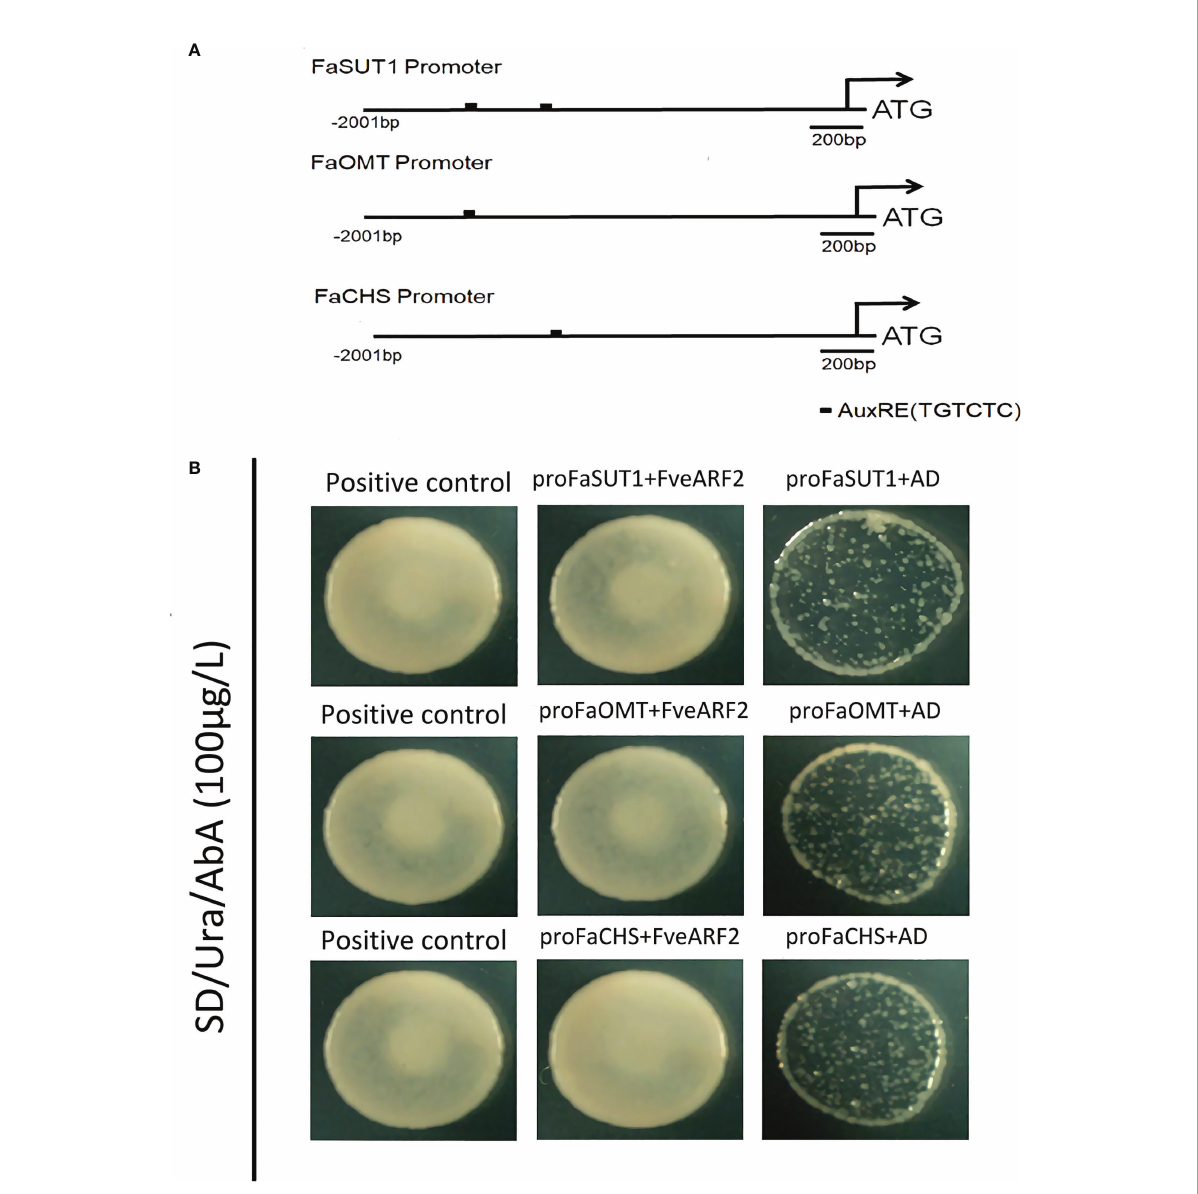
FIGURE 7 Y1H hybrid between FveARF2 and FaSUT1, FaOMT, and FaCHS promoters. (A) Structural diagram of FaSUT1 , FaOMT , and FaCHS promoters. The block represents the AuxRE element (TGTCTC). (B) FveARF2 can bind to FaSUT1 , FaOMT1 , and FaCHS promoter in vitro . Positive control: p53:: AbAi+p53::pGADT 7